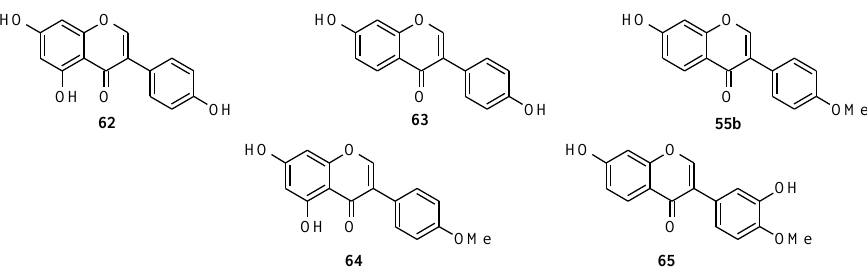
Figure 5. Structures of soy